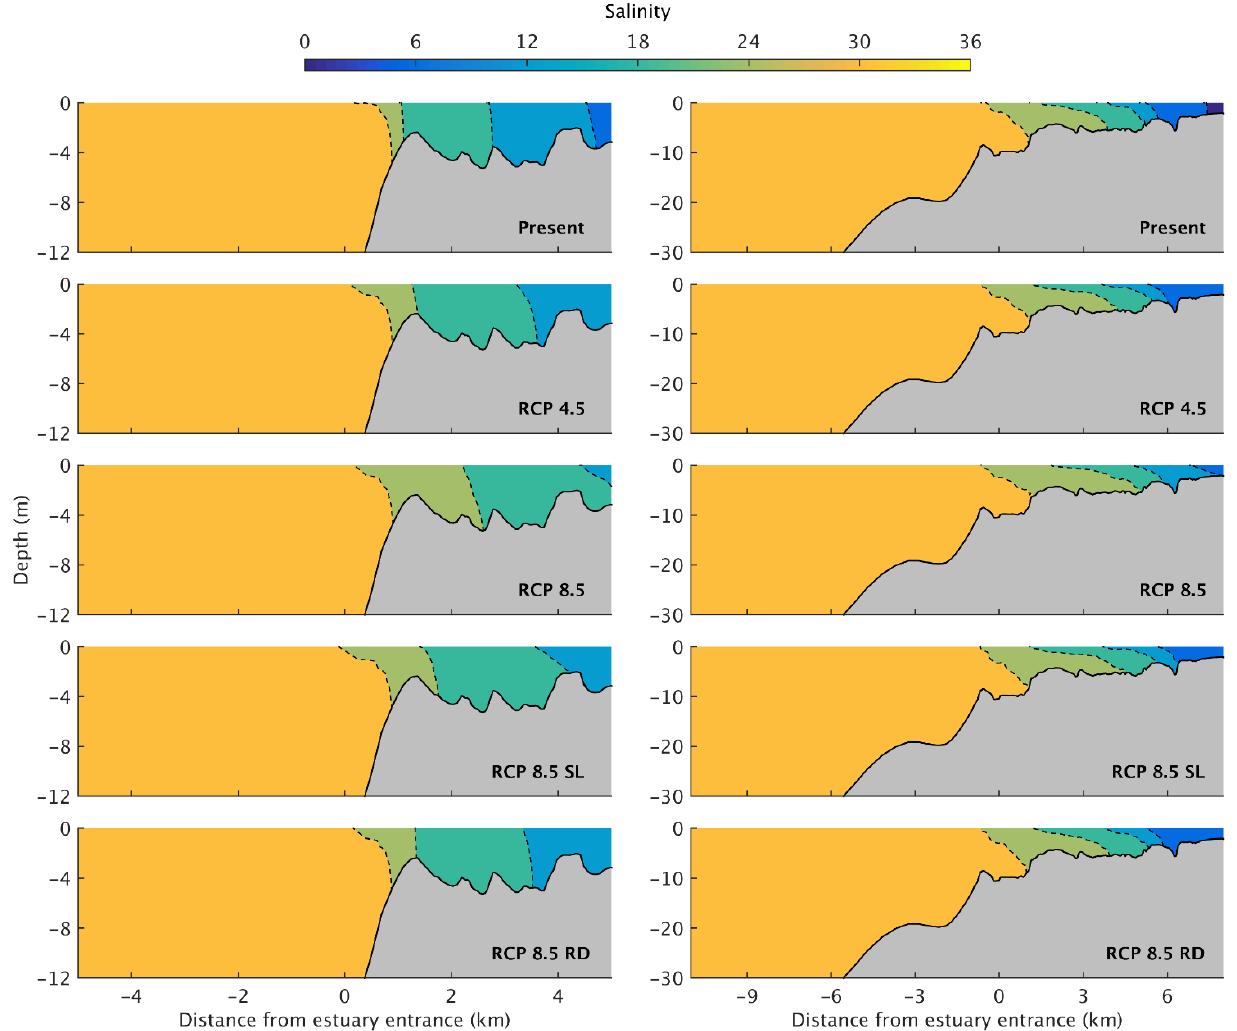
Figure 9. Estuarine plume during summer conditions. The left map represents the average saline distribution for the Present scenario, and the centre and right maps the differences between the RCP 4.5/RCP 8.5 scenarios and the Present scenario, respectively.